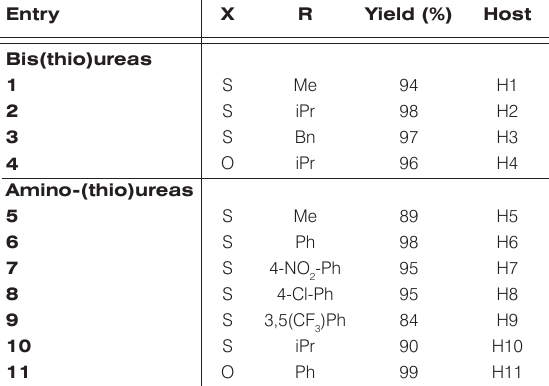
Table 1. Synthesis of the hosts .